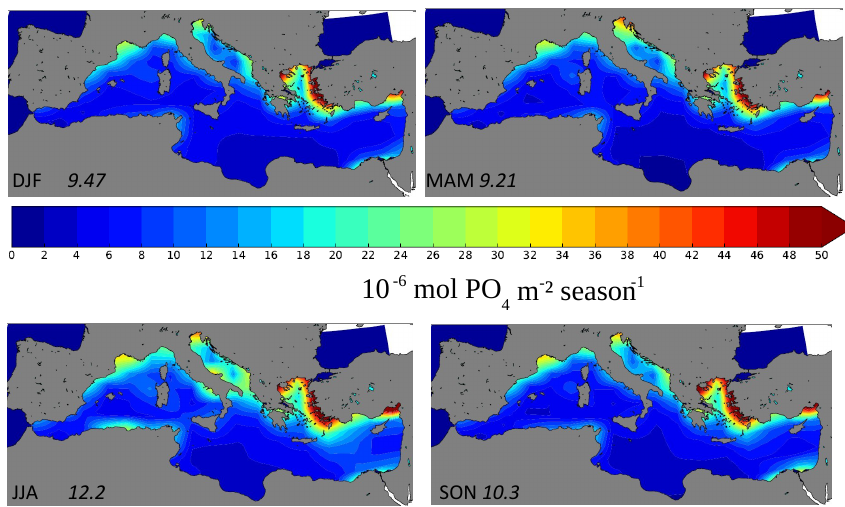
Figure 6. Total seasonal combustion-derived soluble phosphorus deposition (Pcomb in 10 − 6 molPO 4 m − 2 season − 1 ) over each season of the year 2005 (molar flux is calculated as mass flux/phosphorus molar weight) from the LMDz-INCA model. Numbers on the maps are the average seasonal deposition fluxes over the basin in 10 − 6 molPO 4 m − 2 season − 1